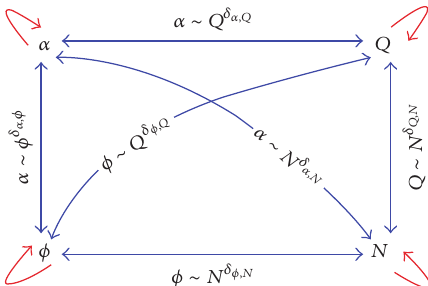
Figure 1: The figure shows the positive feedback loop among the system variables, 𝛼 , 𝜙 , 𝑄 , and 𝑁 and their corresponding scaling